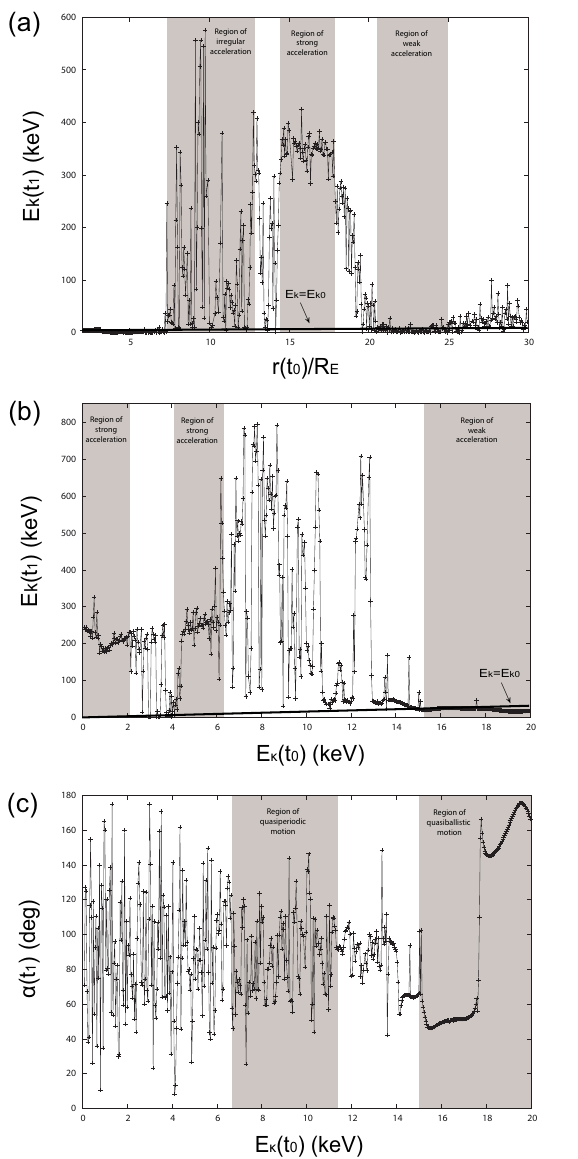
Figure 9. E k (t 1 ) from N ens = 1000 O + particles with initial con- ditions, unless otherwise stated, same as in Fig. 6, vs. (a) r(t 0 ) for 2 R E < r(t 0 ) < 30 R E and (b) E k (t 0 ) for 0.5keV < E k (t 0 ) < 20keV. (c) α(t 1 ) vs. E k (t 0 ) for the same scenario as in (b) .